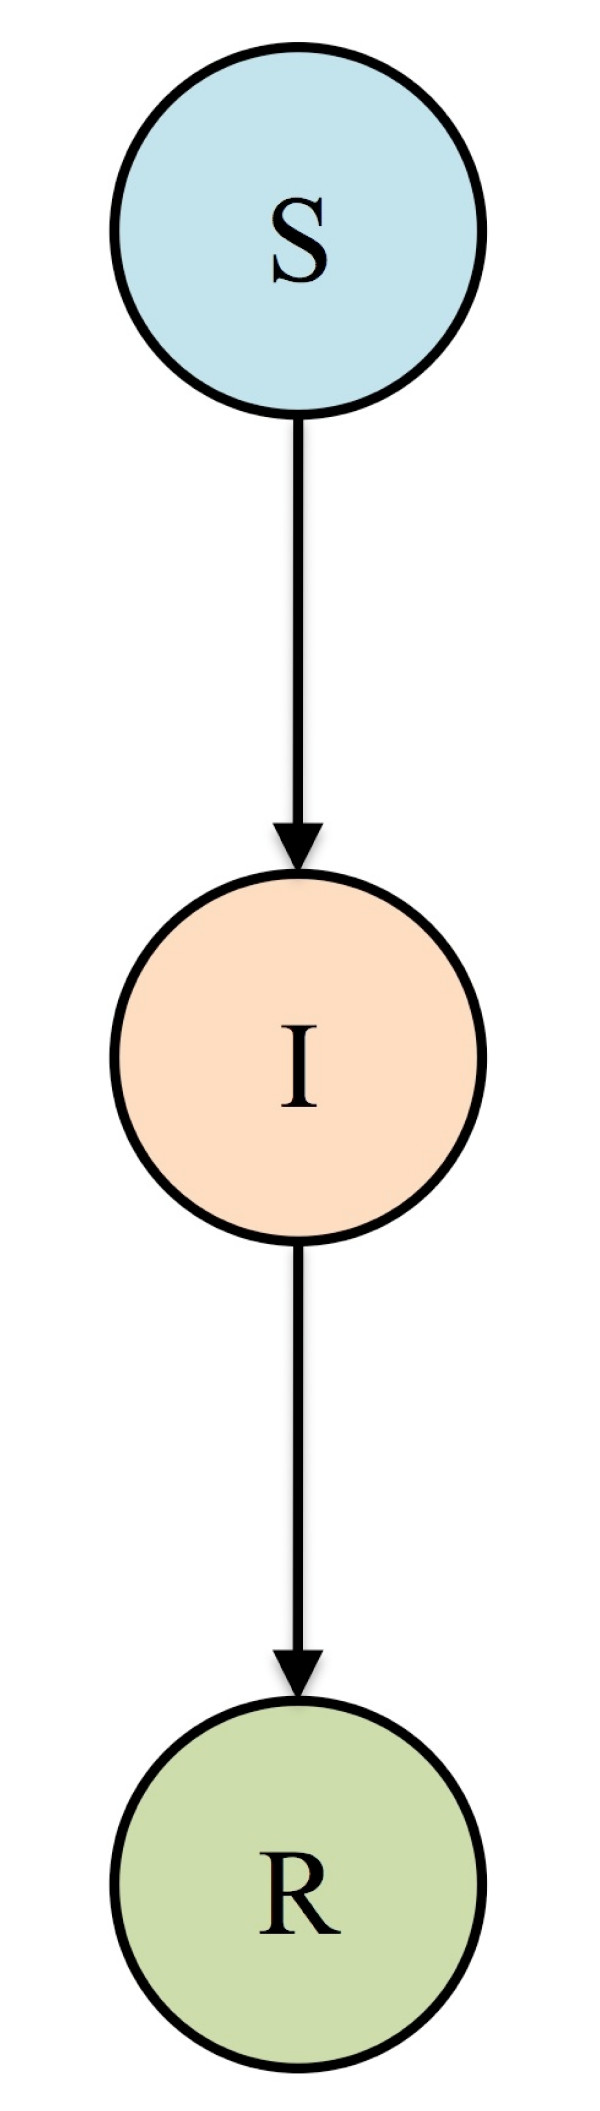
Compartmental SIR model of disease transmission. The population is partitioned into three classes: Susceptible (S), Infectious (I), and Recovered (R). Individuals who become infected proceed from class S to class I at a rate which depends on the infectiousness of the virus and the prevalence of infection. Infectious individuals recover and move to class R, at which point they are immune to future infection. The model can be straightforwardly extended to include immunity which wanes over time.